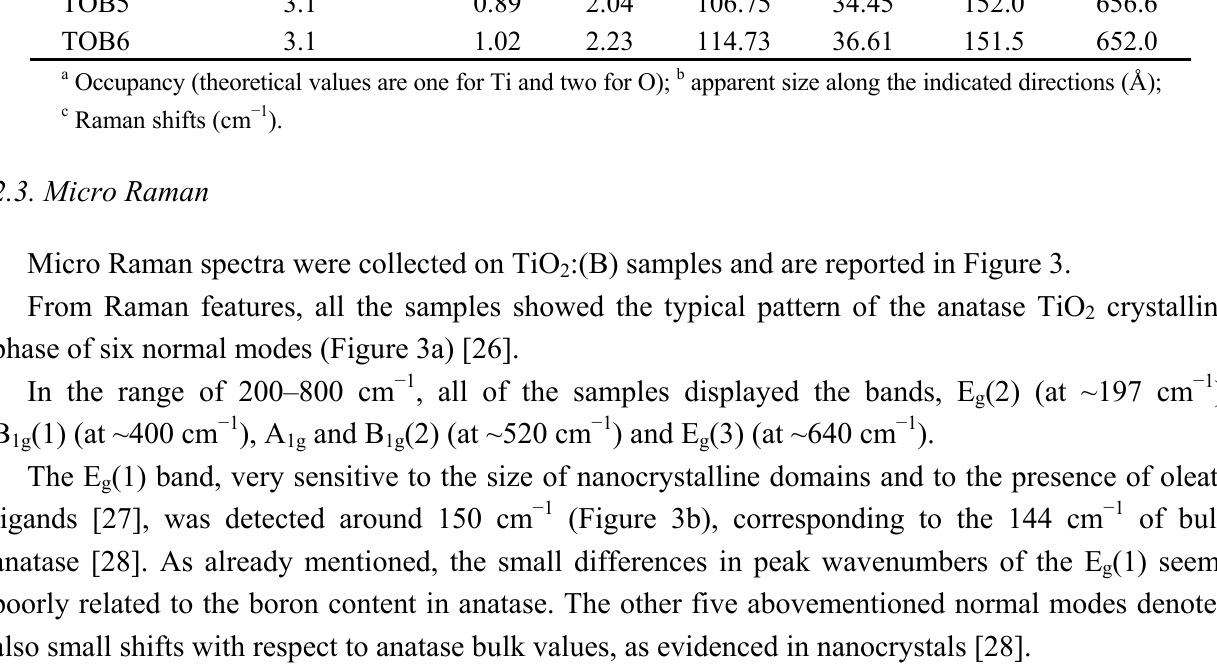
:(B) nanocrystals and Raman shift values of two 2